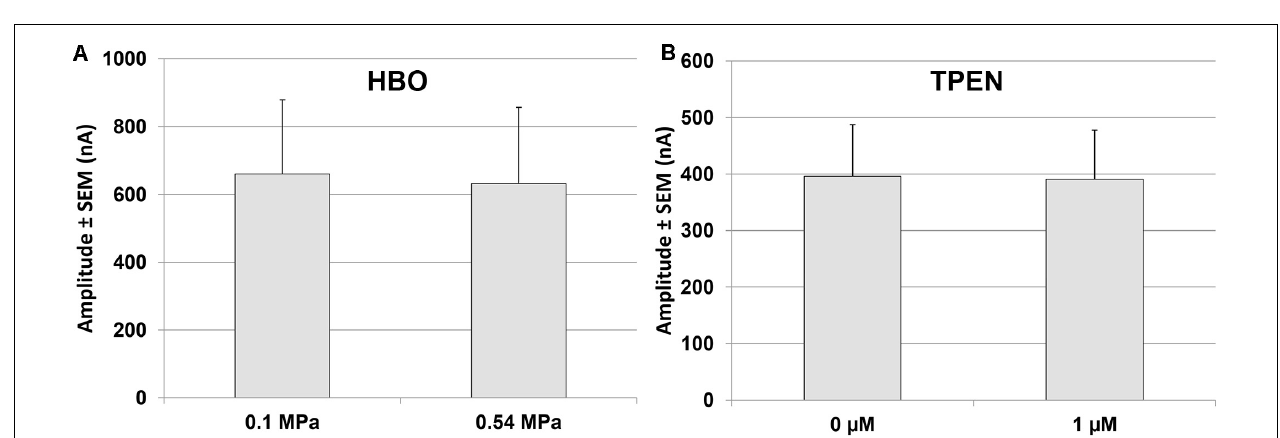
FIGURE 4 | Quantitative analysis of GluN1-1a + GluN2A current changes in HP He and HBO with and without TPEN. Current amplitude is expressed as mean ± SEM in control (0.1 MPa), 0.54 MPa O 2 and 5.1 MPa He, with 0 µ M or 1 µ M TPEN. Splice variant GluN1-1a was co-expressed with the GluN2A subunit. Numbers in the bars indicate number of oocytes tested. ** p < 0.005, *** p < 0.001.